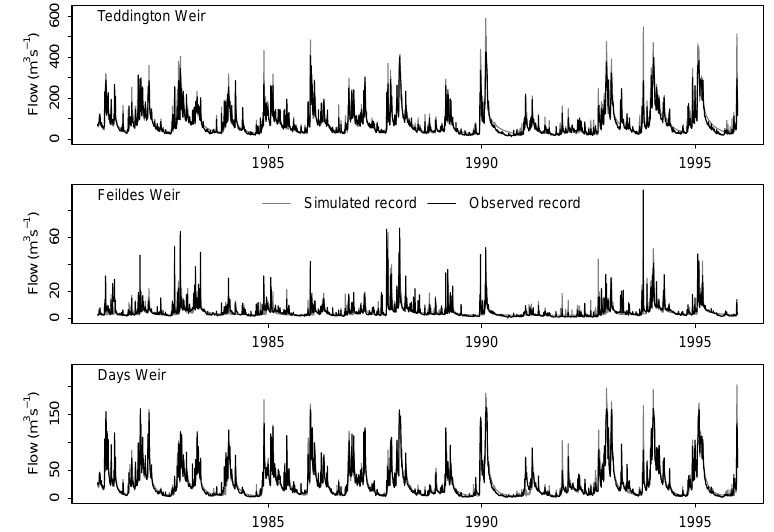
Figure 3. Validation of CATCHMOD reproduction of observed flows. The calibration period against historical flows was 1 January 1961– 31 December 1978 for Teddington and Days Weir, and 1 January 1961–31 December 1975 for Feildes Weir. The validation period for